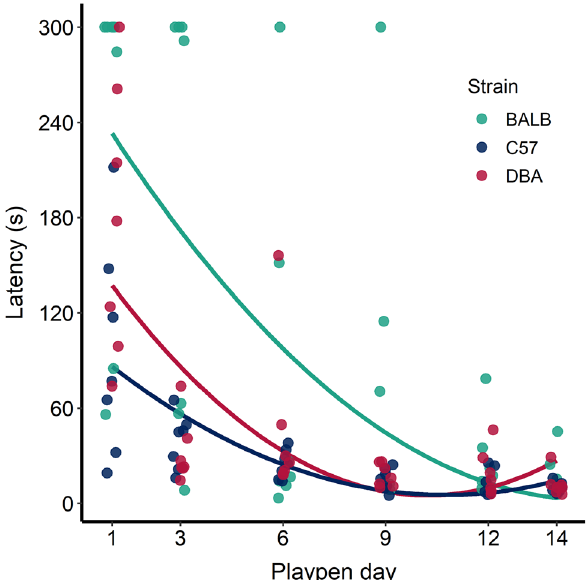
Figure 2. Latency (s) for each mouse to voluntarily enter the playpen. Mice are shown as individual points (horizontally jittered to avoid fully overlapping points) while genetic strains are shown in different colours. Lines depict model output; note that the quadratic term was included for all three lines for consistency in visualization, but for the BALB mice the quadratic term was not significant. The maximum possible latency was 300 s. Seven mice were tested of each